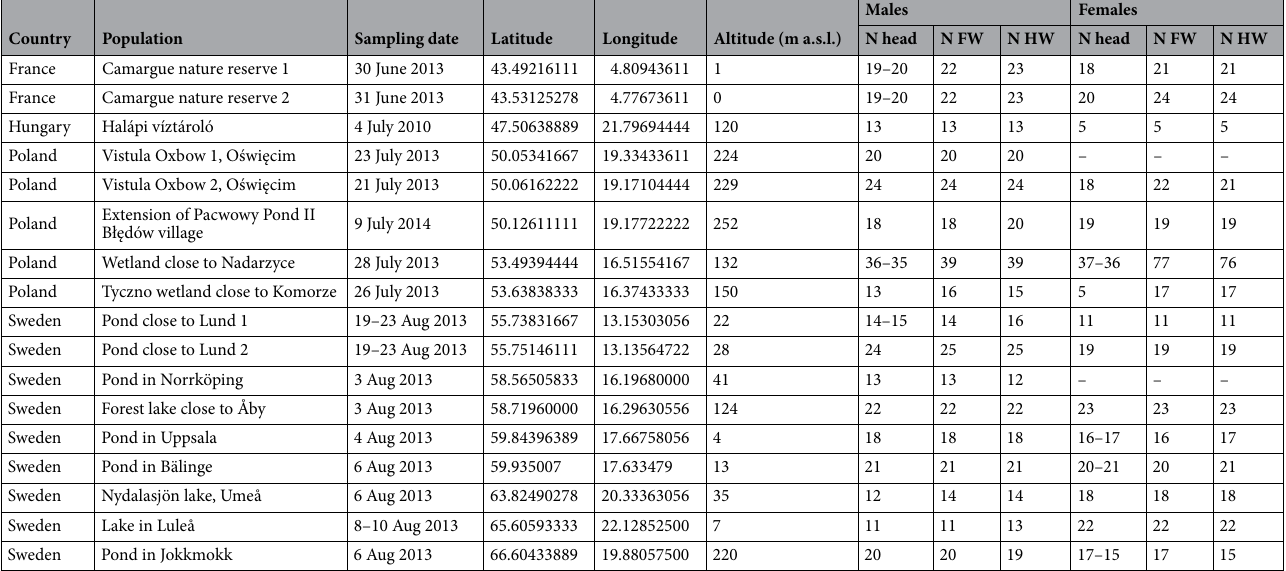
Table 4. Sample size (N) of males and females of Lestes sponsa studied at each population including country of origin, sampling date, latitude and longitude, and altitude (head: head width, FW: forewings, HW: hindwings). The sample size for measurements of head width is variable depending on the corresponding measurements for fore- and hindwings of the same individual (N head FW-N head HW). No females were captured in the populations of Vistula Oxbow 1 Oświęcim (Poland) and Norrköping